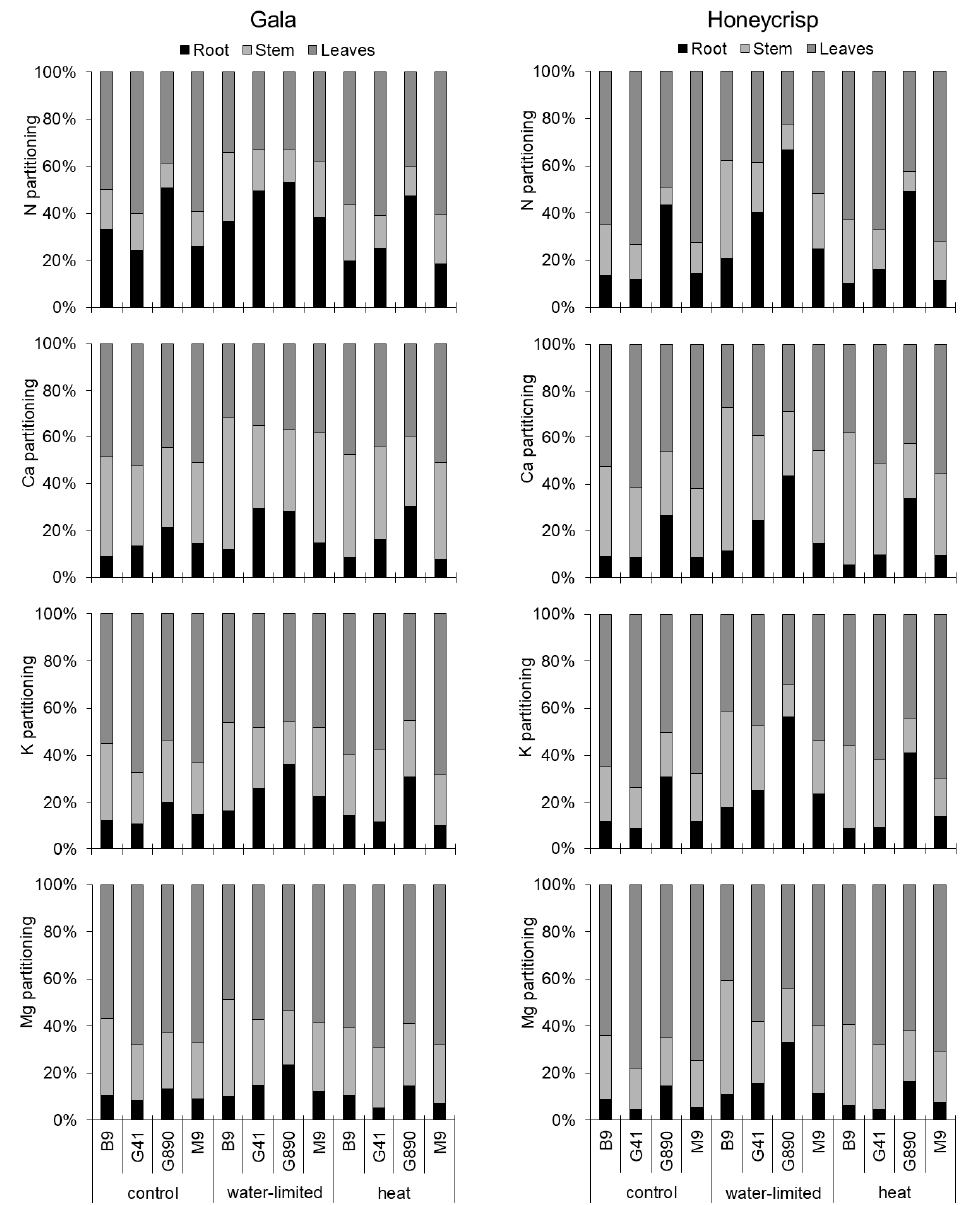
Figure 5. Total tree nitrogen, calcium, potassium and magnesium partitioning (%) between roots, stems and leaves for ‘Gala’ and ‘Honeycrisp’ apple scion genotypes grafted on B9, G41, G890, and M9 rootstocks grown under water-limited or elevated soil temperature treatments compared to an untreated control.